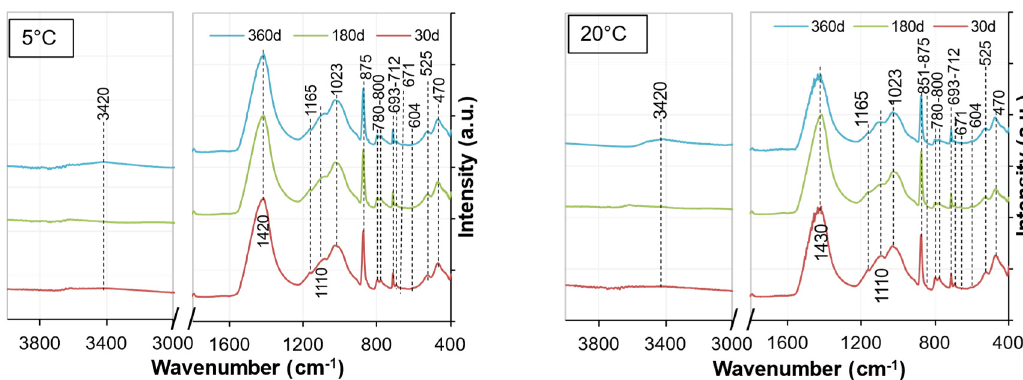
Figure 20. FTIR spectra of Sg + S + FA + W2.